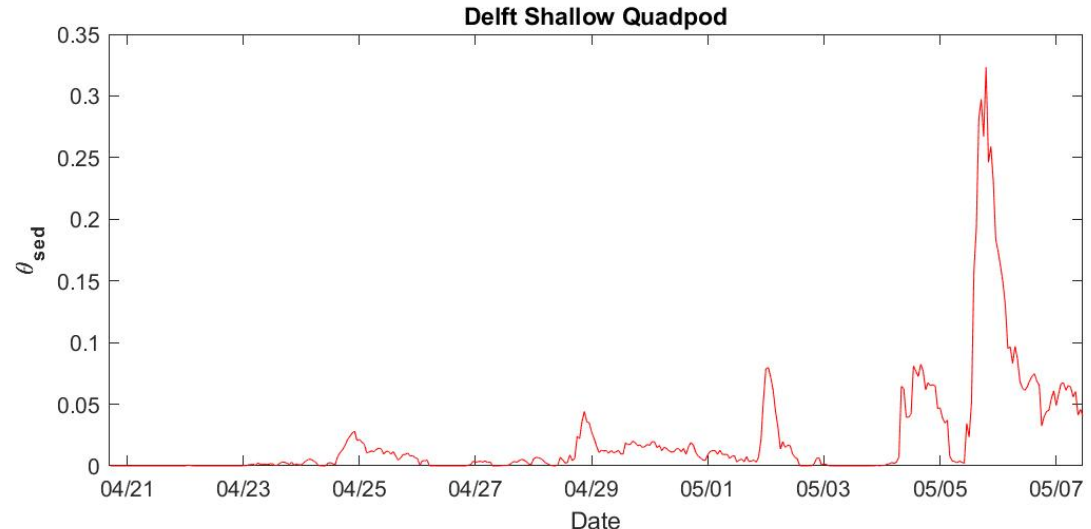
Figure 9. Time series of sediment Shields parameter ( θ sed ) at the shallow quadpod computed from the Delft3D model output.